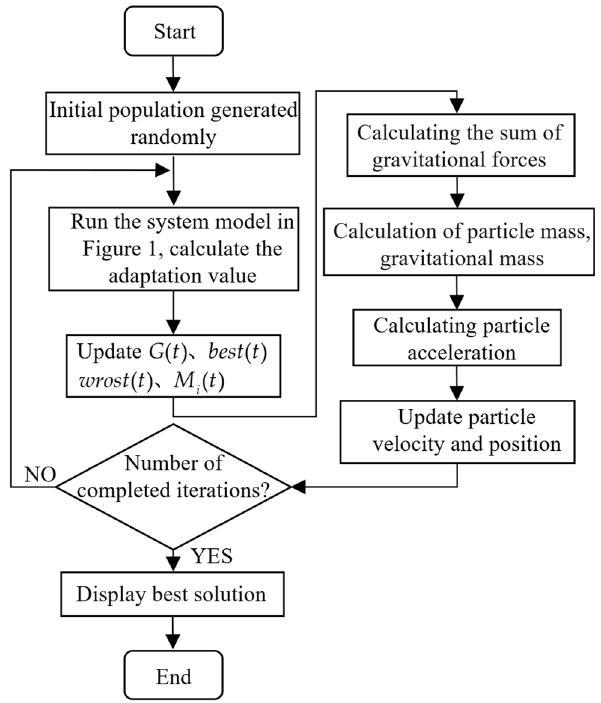
Figure 5. Flow chart of algorithm optimization.